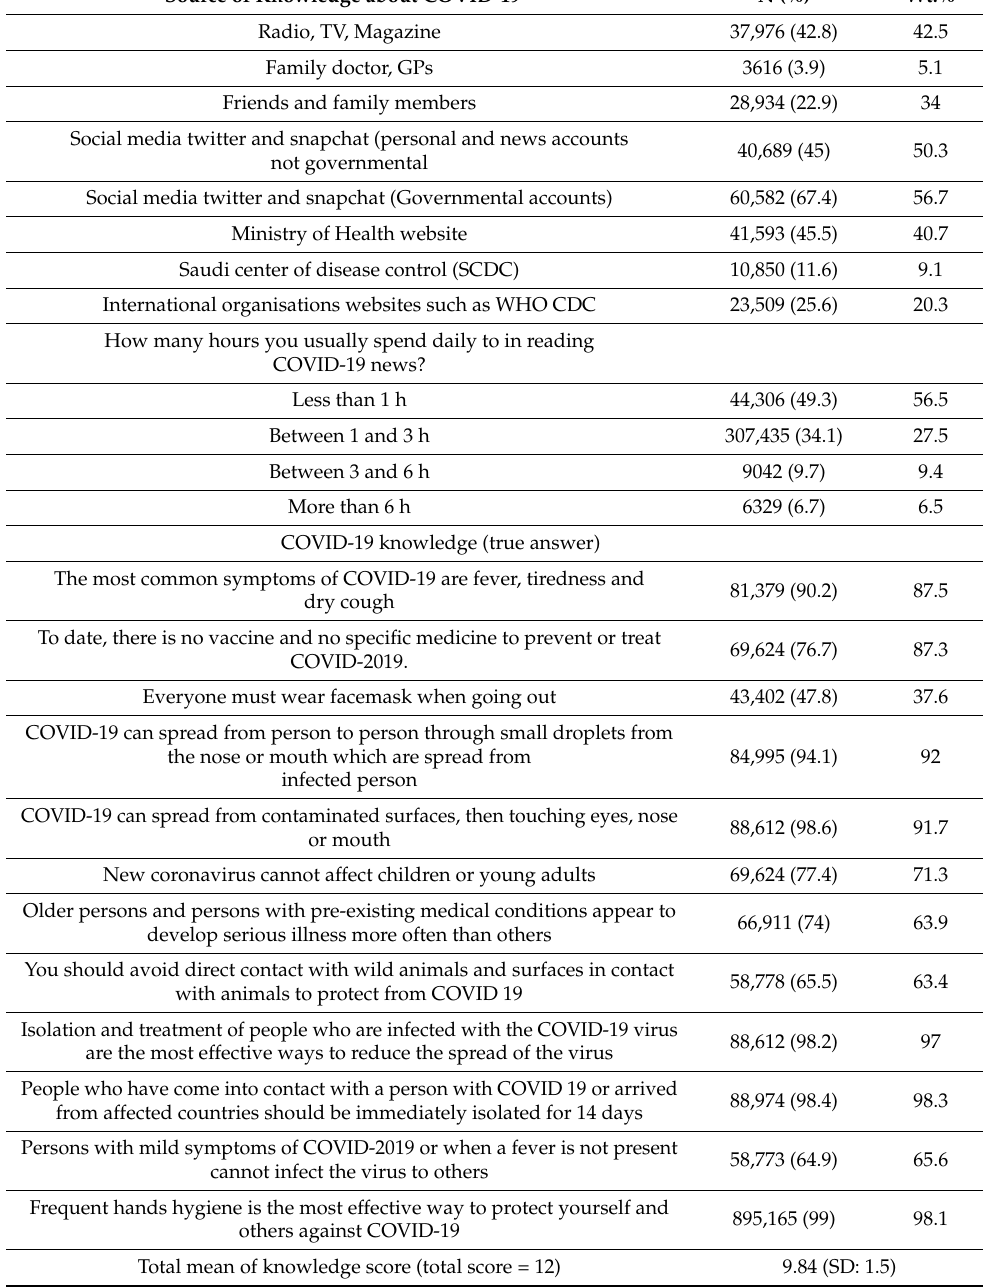
Table 2. Public knowledge and source of knowledge levels about